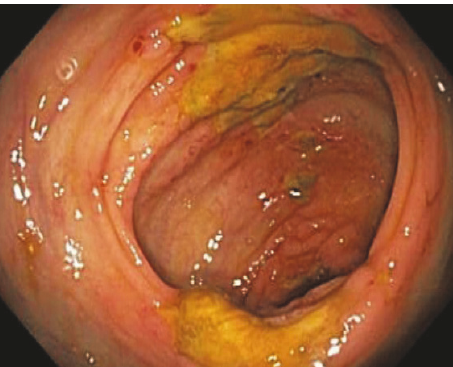
Figure 17: Endoscopic image of medication induced mucosal injury in the ileocecum, on the valve and the opposite of the valve. In this case, medication crystals are found on biopsy specimen.